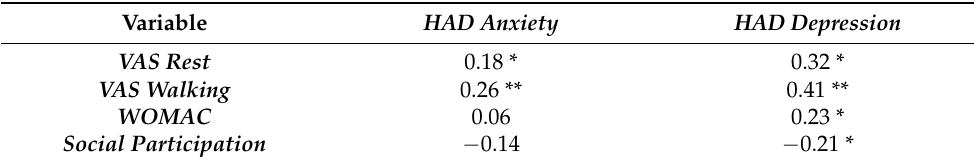
Table 4. Correlation